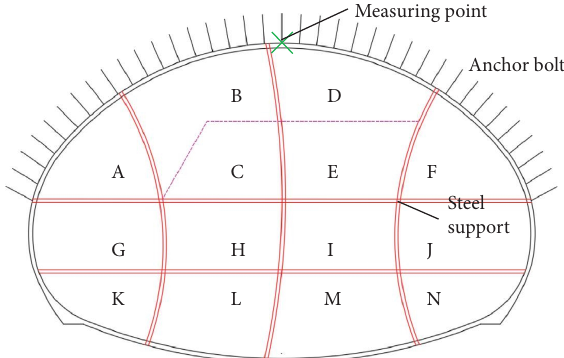
Figure 3: 14-step excavation practice combining double sidewall heading and CRD